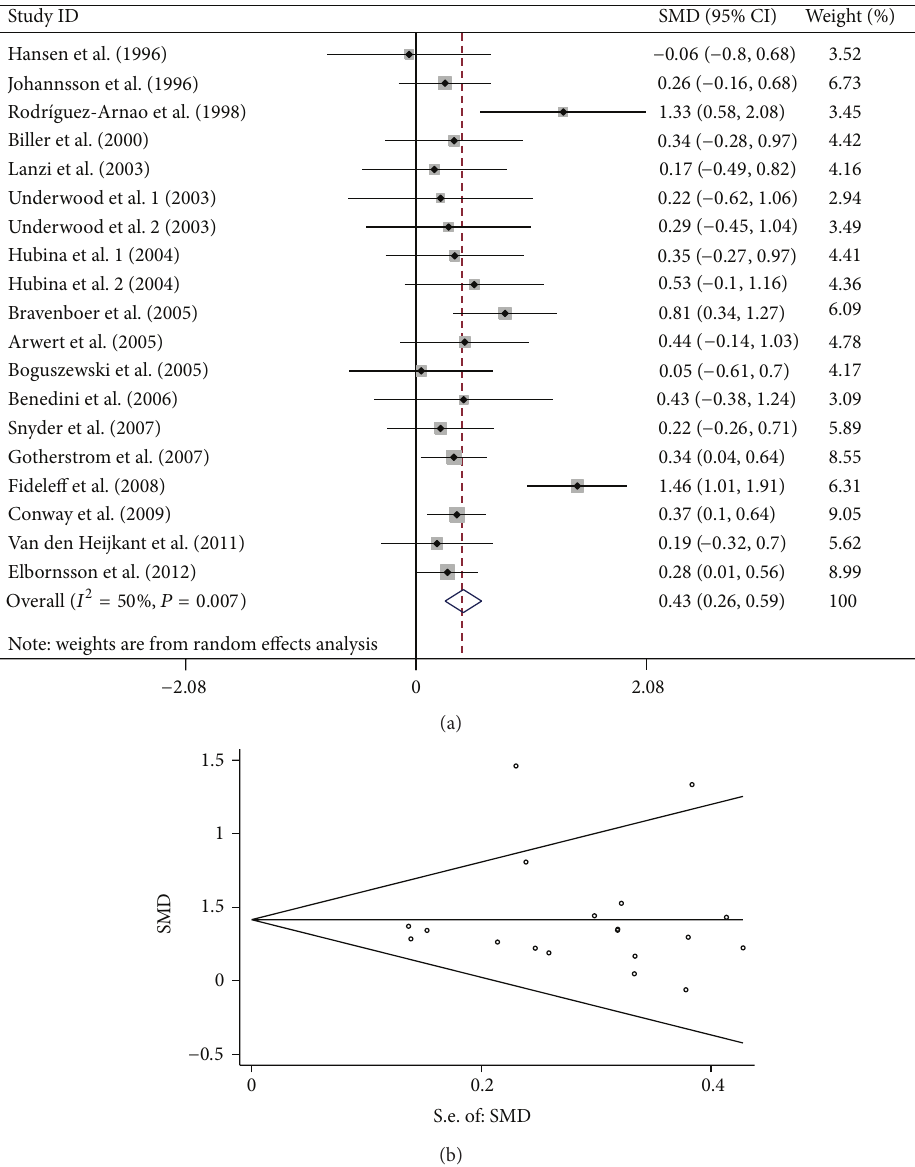
Figure 1: Forest plot and funnel plot for the association between GH treatment and BMD of spine. (a) Forest plot using a random effects model. (b) Funnel plot using Begg